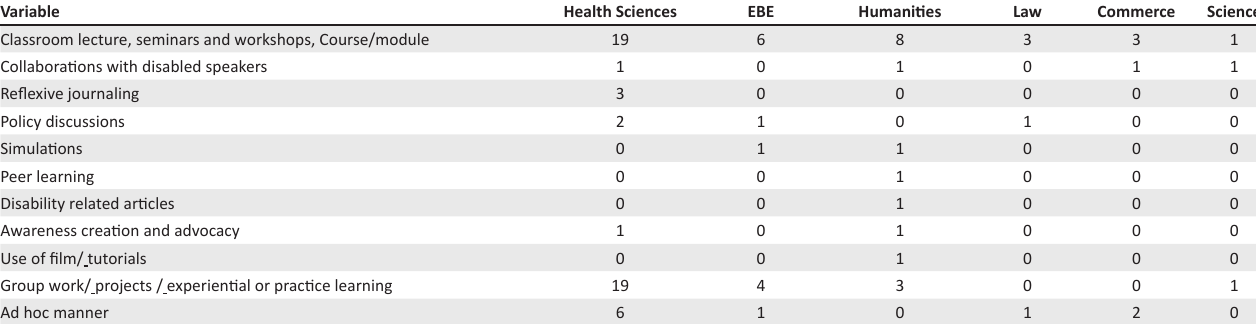
TABLE 4: Teaching